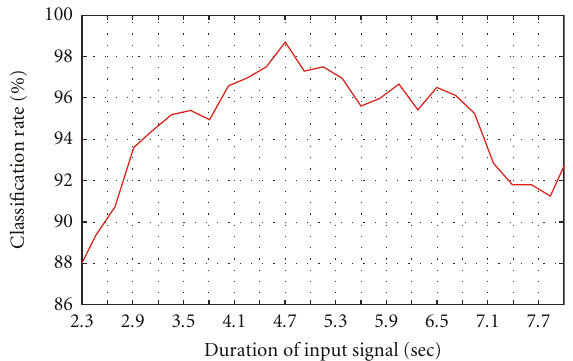
Figure 7: Classification rate as a function of the duration of the input